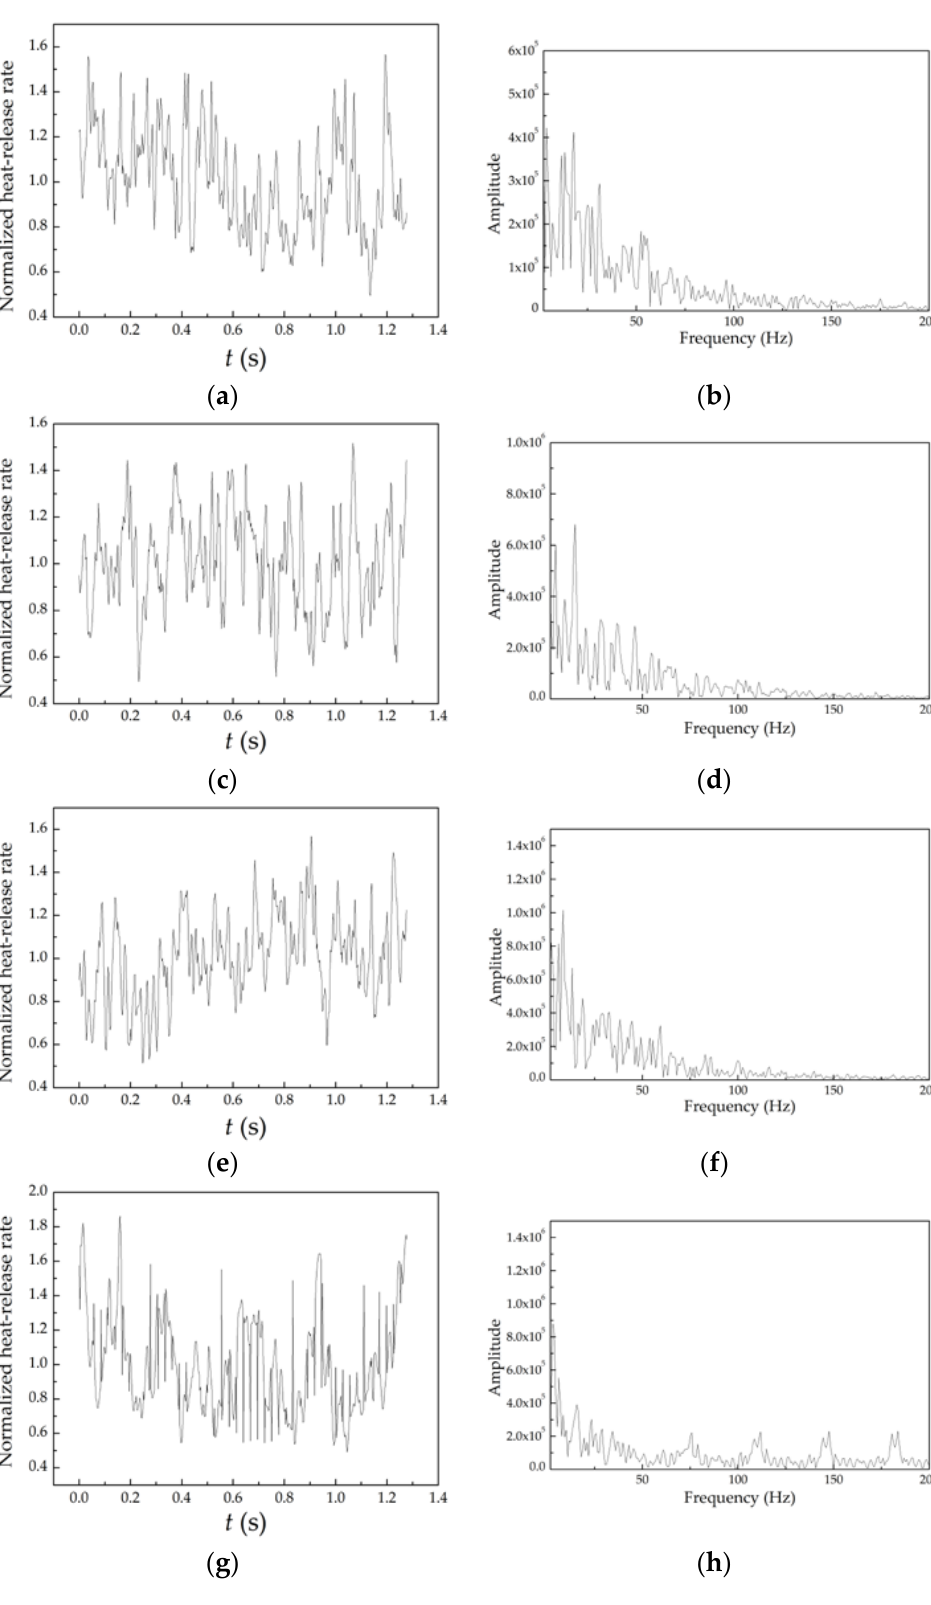
Figure 11. Flame heat-release rate pulsation curves and corresponding spectrum curves for injector exit velocity: ( a ) pulsation curve at v e = 2.56 m/s; ( b ) spectrum curve at v e = 2.56 m/s; ( c ) pulsation curve at v e = 3.16 m/s; ( d ) spectrum curve at v e = 3.16 m/s; ( e ) pulsation curve at v e = 3.76 m/s; ( f ) spectrum curve at v e = 3.76 m/s; ( g ) pulsation curve at v e = 4.35 m/s; ( h ) spectrum curve at v e = 4.35 m/s.